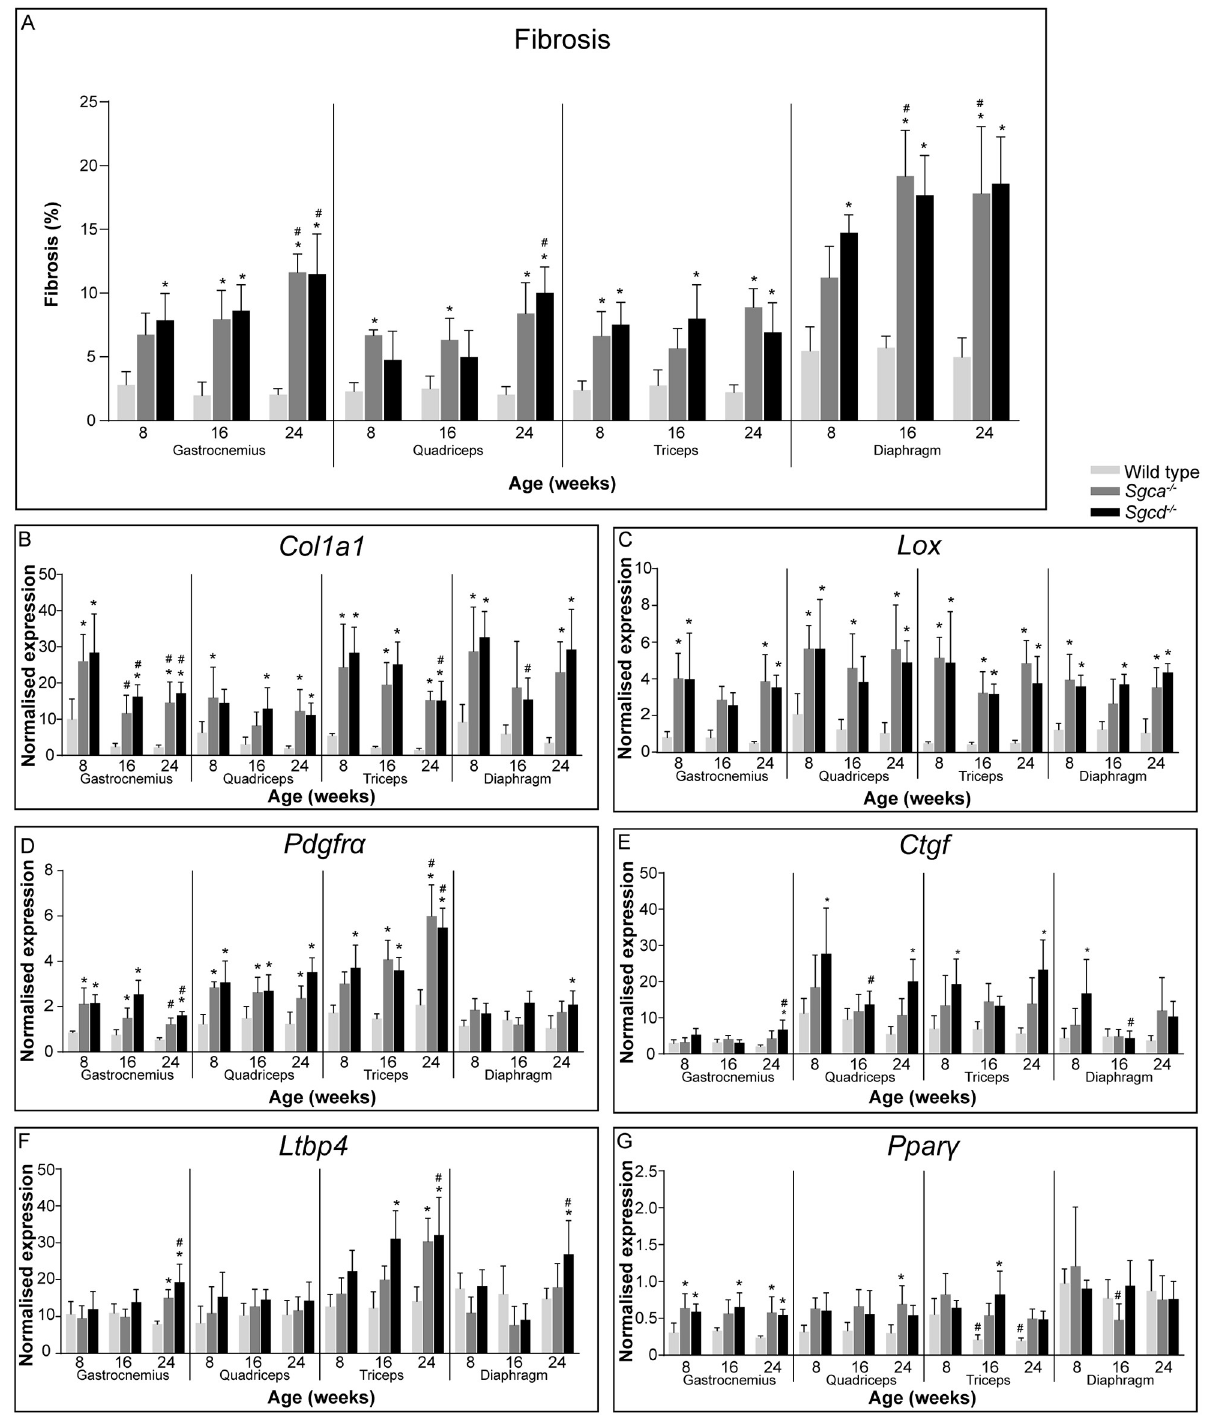
Fig 3. Fibrosis and fat formation in Sgca -/- and Sgcd -/- males. (A) Quantification of fibrosis by Sirius Red staining. (B-F) Gene expression of fibrotic markers Col1a1 (B), Lox (C), Pdgfr α (D), Ctgf (E) and Ltbp4 (F). (G) Gene expression of Ppar γ , a marker for fatty infiltration. N = 5-6 male mice per group. � p < 0.05 vs age-matched wild type mice, # p < 0.05 over time (same genotype).